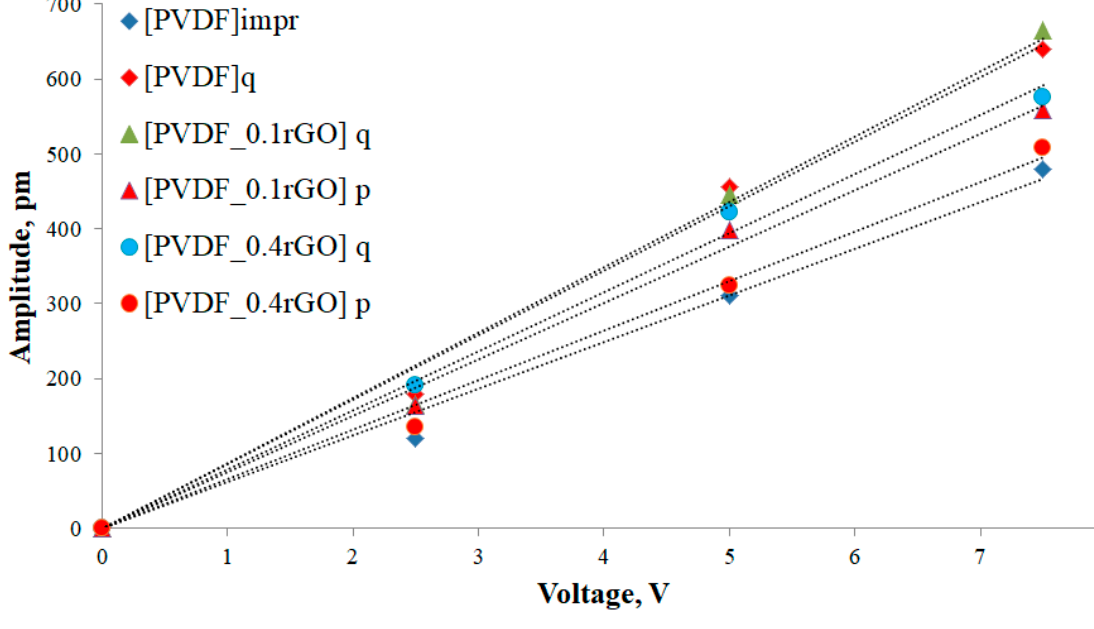
Figure 11. The measured piezoelectric signal, averaged over 4 different areas, versus the amplitude of the applied ac voltage. Table 4. Piezoelectric coe ffi cient evaluated by averaging the PFM signal over 4 areas with dimensions of 20 × 20 µ m in comparison with other published